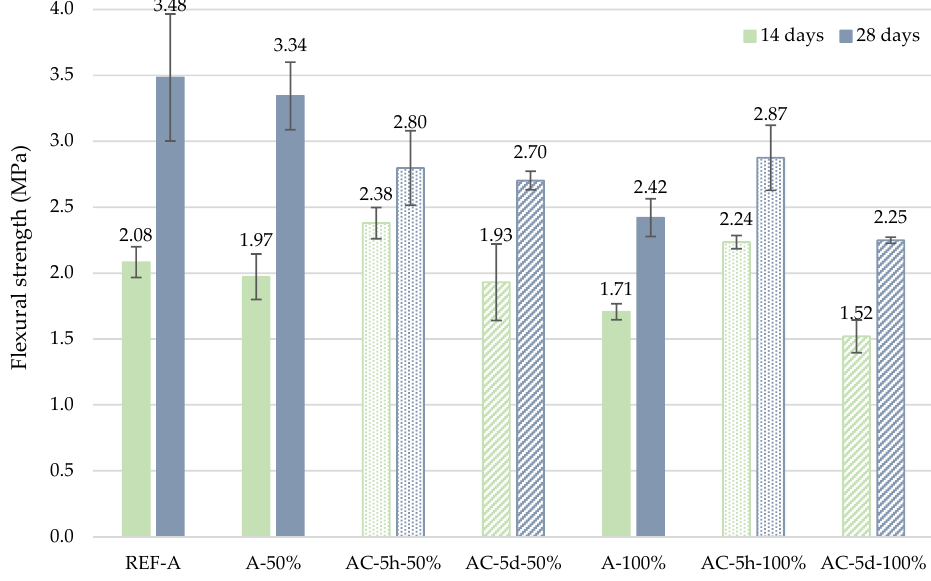
Figure 7. Flexural strength results.